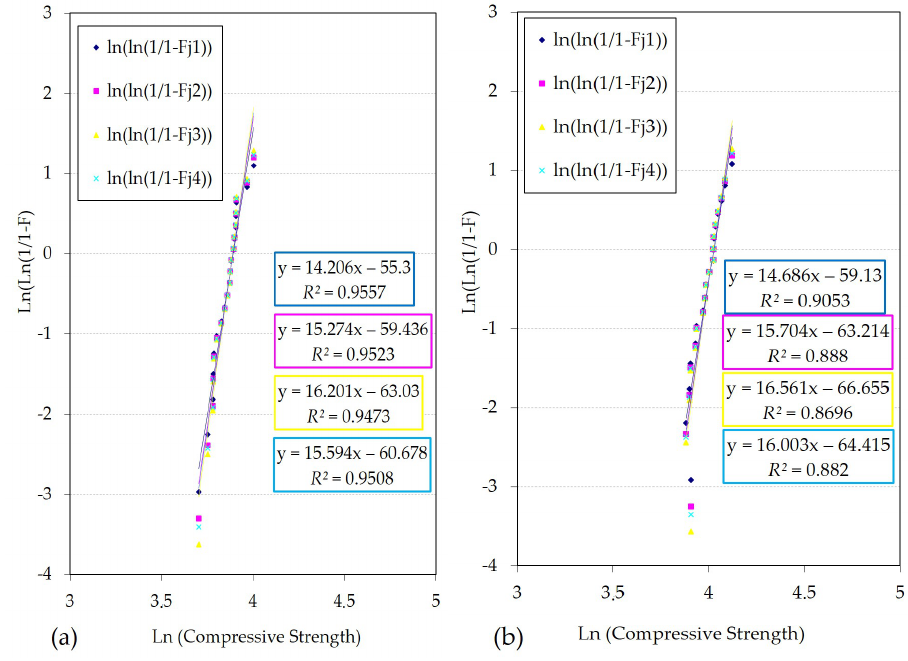
Figure 13. Weibull graphs for the series: ( a ) A series and ( b ) B